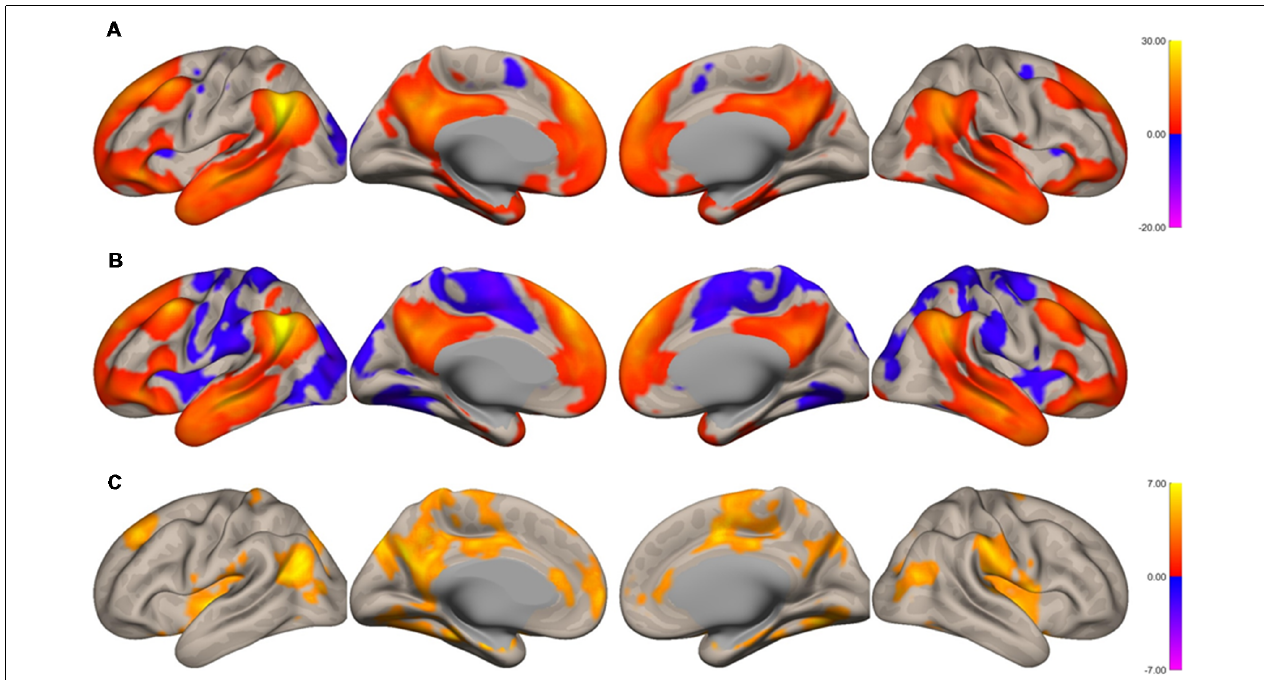
FIGURE 1 | Surface maps of functional connectivity of the left angular gyrus (AG) as the seed region. (A) Imagined music performance. (B) Resting state. (C) Voxels with significant differences in connectivity with the left AG in imagined music performance vs. the resting condition. The significance level was peak-voxel p < 0.001, uncorrected, and cluster p < 0.05, family-wise error corrected.